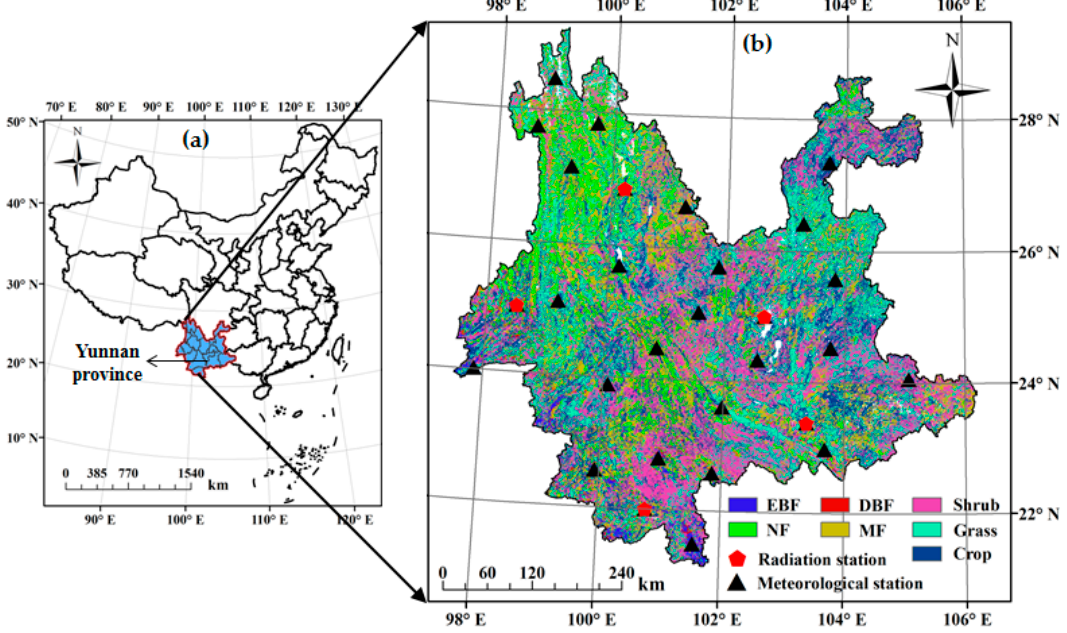
Figure 1. Study area: ( a ) location of Yunnan province in China; ( b ) spatial distribution of vegetation cover and radiation/meteorological stations (EBF: evergreen broadleaf forest; DBF: deciduous broadleaf forest; NF: needle-leaf forest; MF: mixed forest).